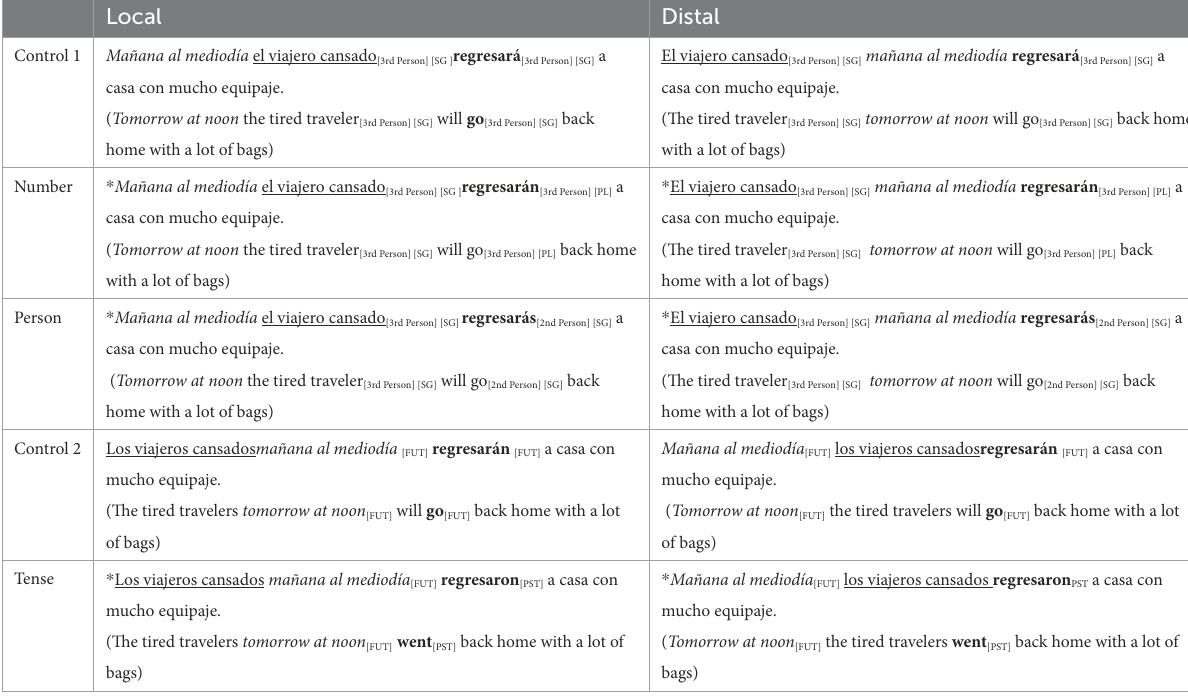
TABLE 2 A sample of the material (SV agreement: control 1, number and person; adverb-verb TC: control 2, tense) in the two configurations (subject/adverb-verb relation: local, distal). Local